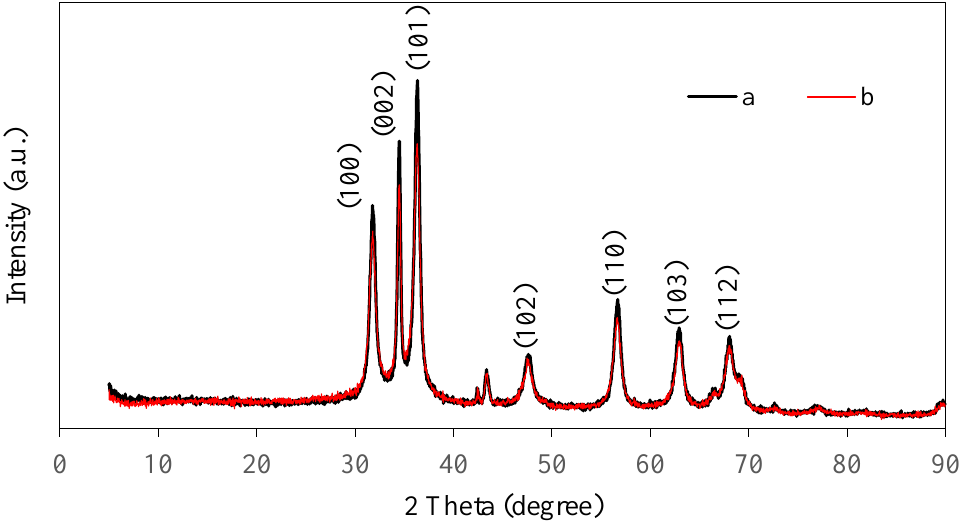
Figure 2. XRD pattern of ZnO NPs synthesized ( a ) with heating (60 °C) and ( b ) without heating (28 °C).